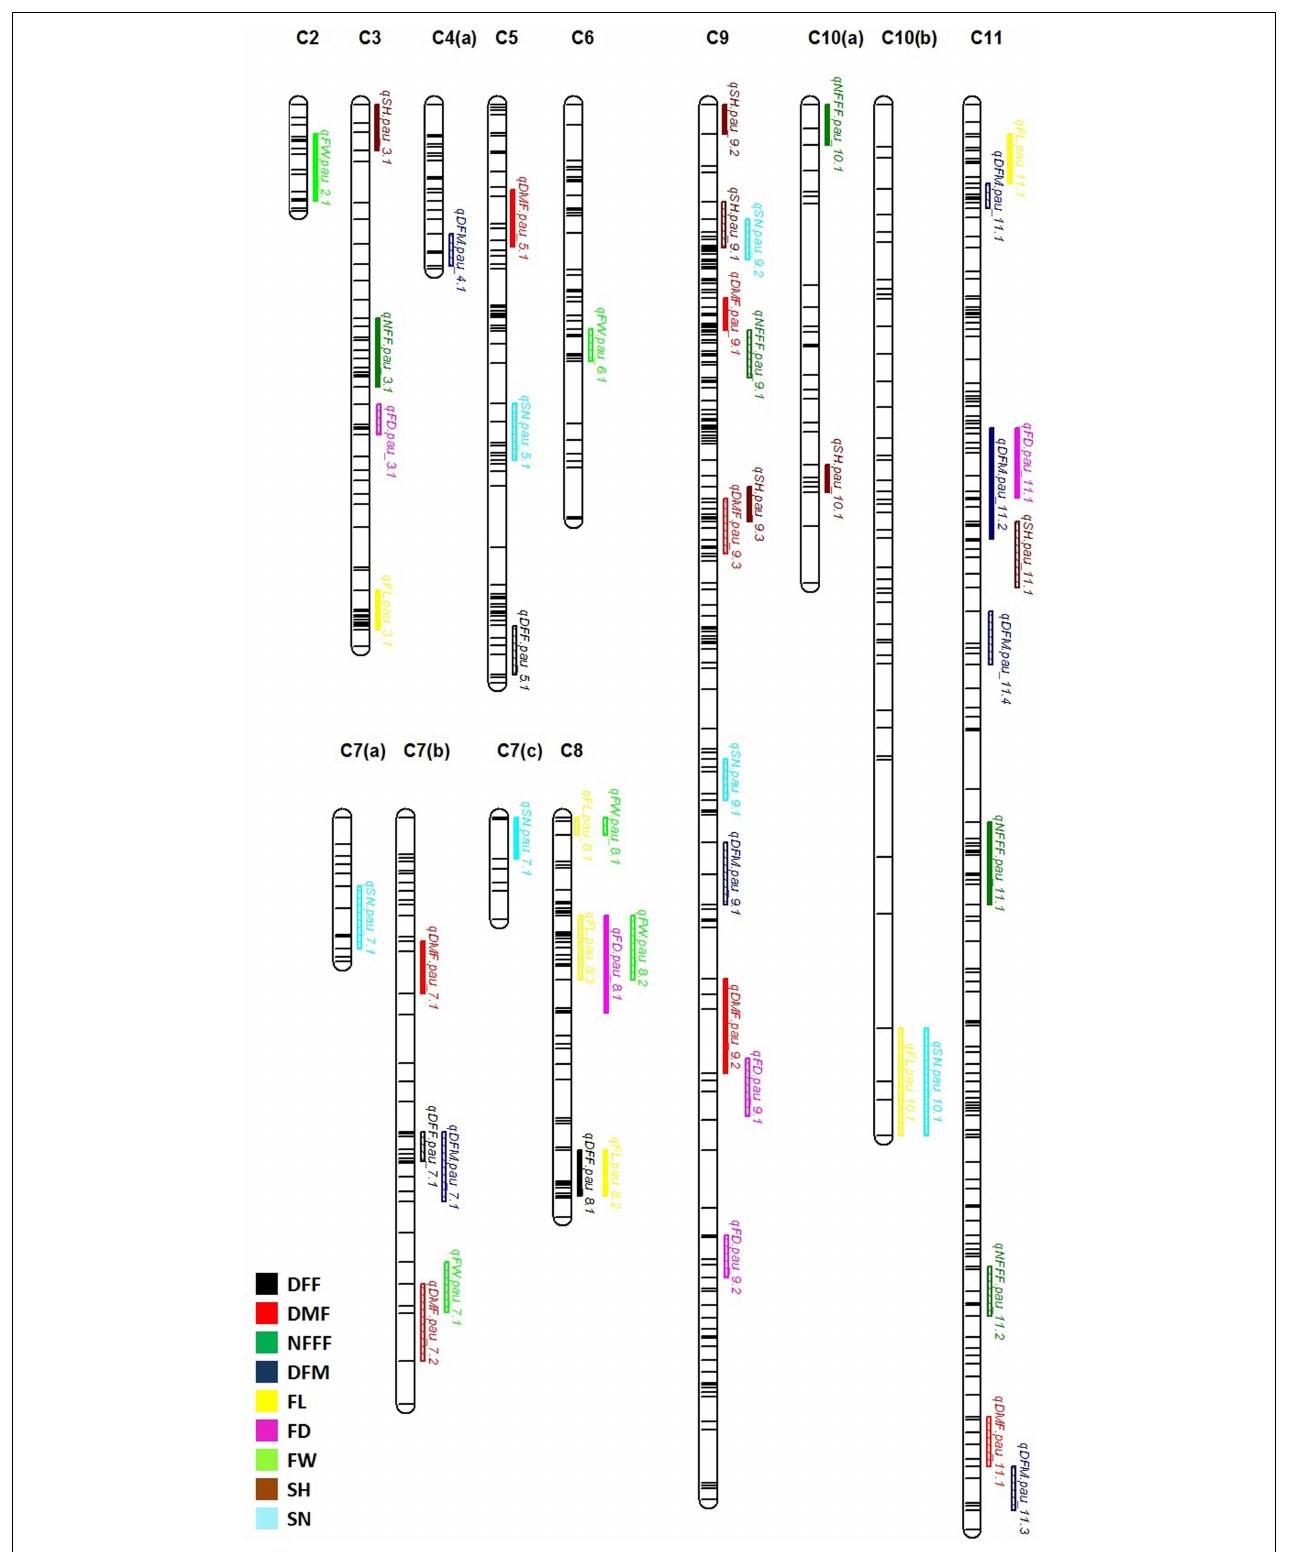
FIGURE 3 | Locations of QTLs for nine horticultural traits based on F 4 population derived from a cross between Punjab-14 and PAUBG-6. The solid bars represent the QTLs in single environment while bars with lines represents frequent QTLs (FQ-QTLs).